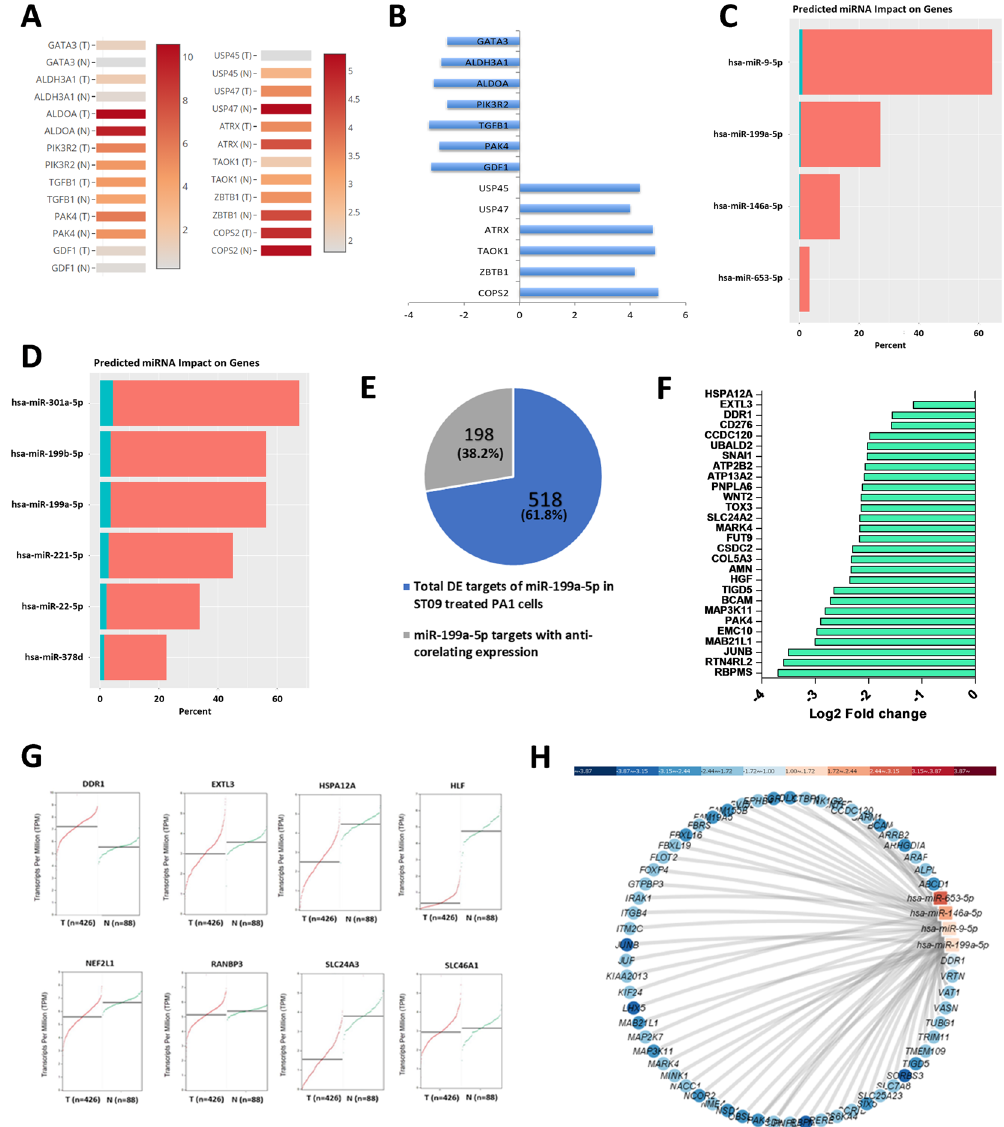
Figure 3. Induction of miR-199a-5p and identification of its targets in ST09 treated PA1 cells. ( A ) Heatmap of the DE genes from ST09 treated PA1 cells depicting their expression pattern in ovarian cancers obtained from GEPIA. ( B) Bar graph depicting reversed expression of these genes upon ST09 treatment in PA1 cells compared to GEPIA ovarian cancer dataset (http:// gepia. cancer- pku. cn/). ( C) Bar plot obtained from miRmapper showing dominant miRNAs in ST09 treated PA1 cells with most impact on mRNA expression. ( D) Bar plot obtained from miRmapper showing dominant miRNAs in ST09 treated A2780 cells with most impact on mRNA expression. The orange bar represents the percentage of targets, and the sea-green bar represents differentially expressed genes. ( E) A pie chart representing the number of miR199a-5p targets differentially expressed in ST09 treated PA1 cells and the number of targets having an anti-correlating expression. ( F) Bar plot showing the expression of miR199a targets in ST09 treated PA1 samples, where the x-axis is log2 Fold change, and the y-axis represents gene names. ( G) Expression of shortlisted miR199a-5p targets in TCGA ovarian cancer database. ( H) mRNA-miRNA interaction map of ST09 treated PA1 cells obtained from miRTarVis (gene names are listed in supplementary